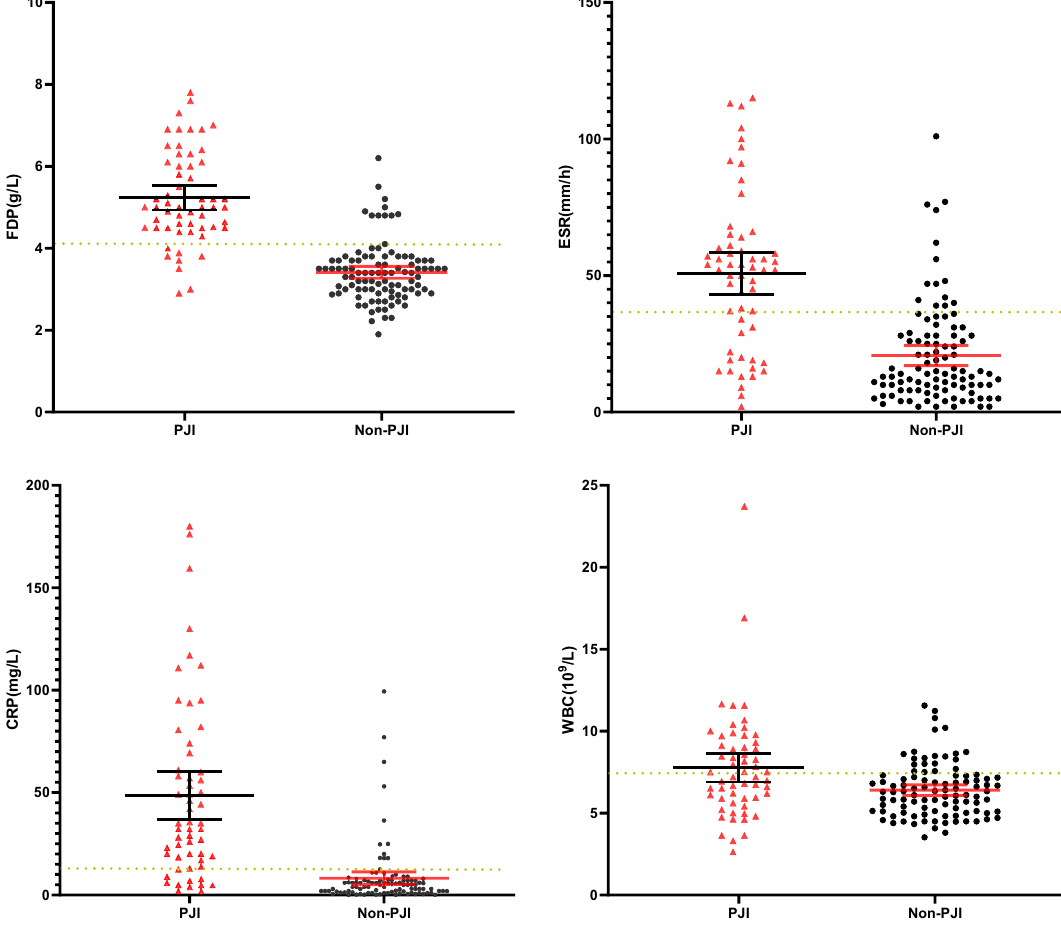
Figure 2. Analyses the distributions of plasma fibrinogen and ESR, CRP and serum WBC count. The solid line represents the average and the 95% CI and the dashed line indicates the optimal cutoff valves in the study, dotted lines represents the optimal cutoff values.